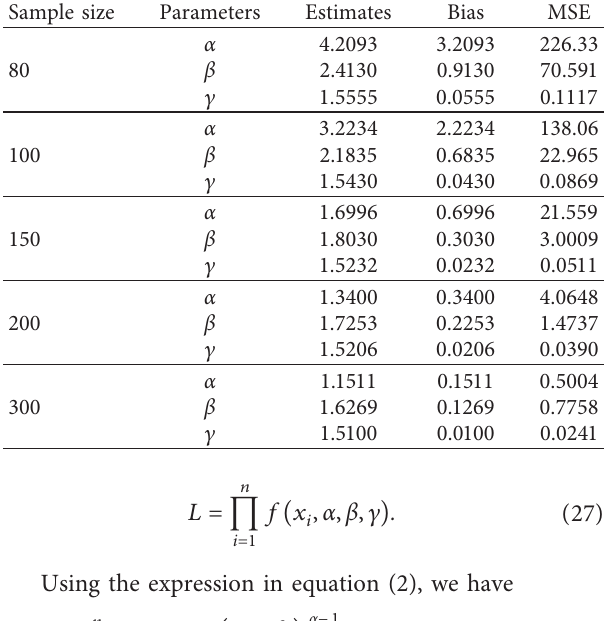
Table 1: Estimates of parameter, bias, and MSE at α � 1.0, β � 1.5, and c � 1.5.